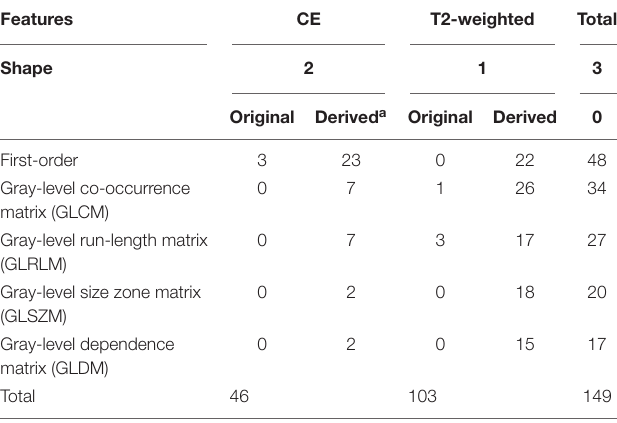
square root, and wavelet features derived from the original features.